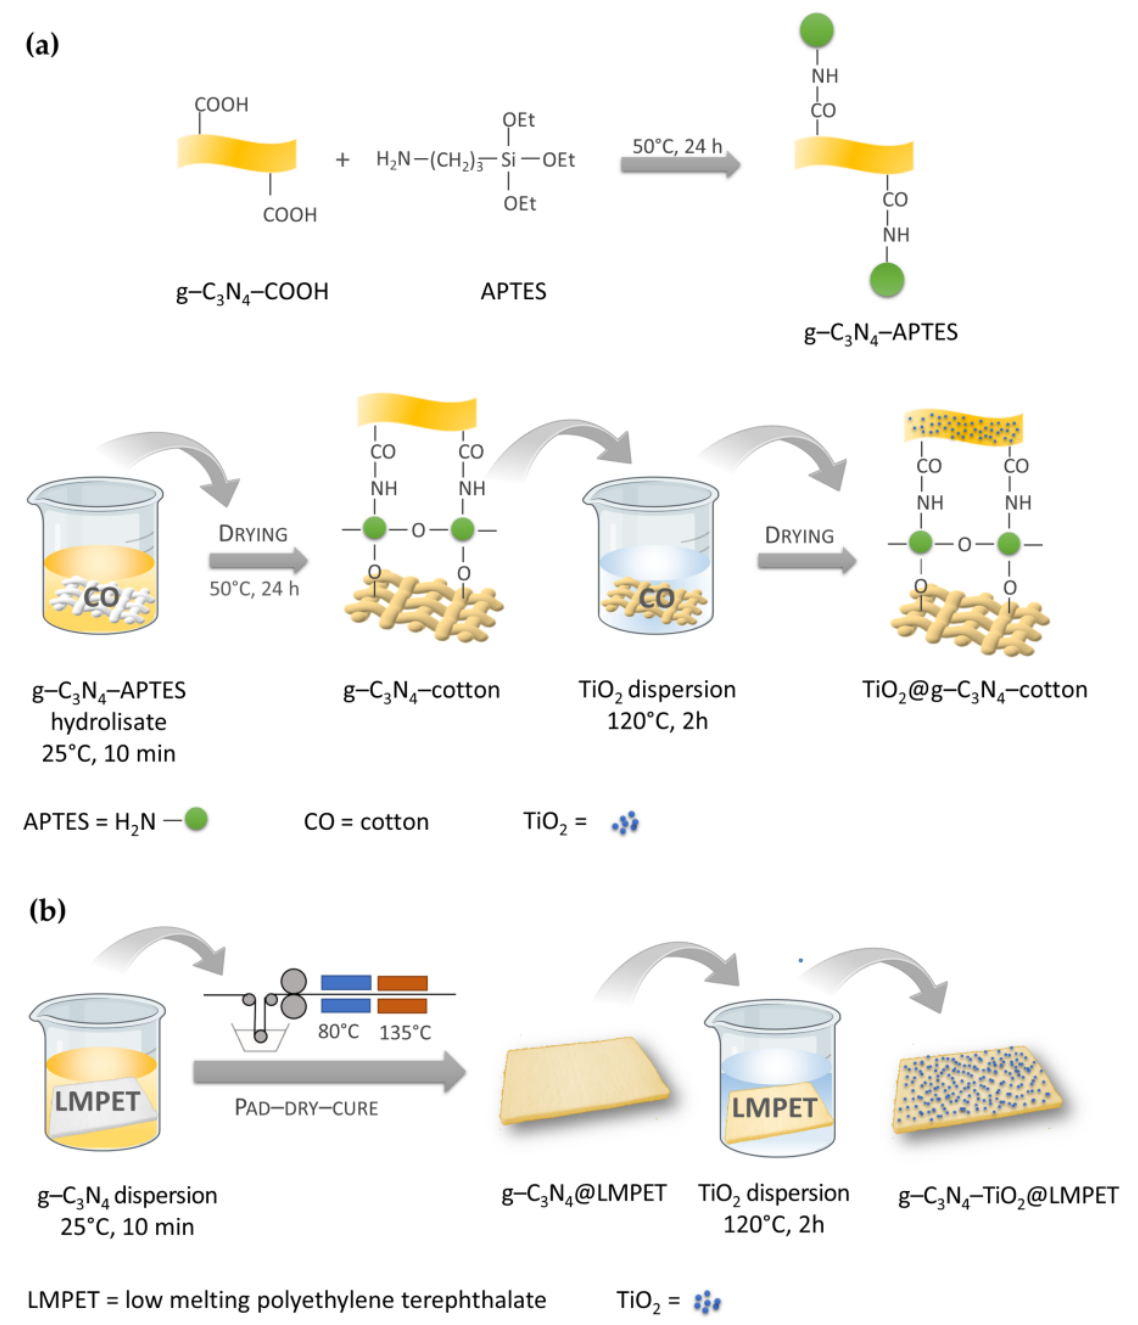
Figure 7. Schematic presentation of the preparation of the TiO 2 @g-C 3 N 4 – cotton ( a ) and the g-C 3 N 4 - TiO 2 @LMPET ( b ) photocatalysts (prepared according to refs. [106,107].